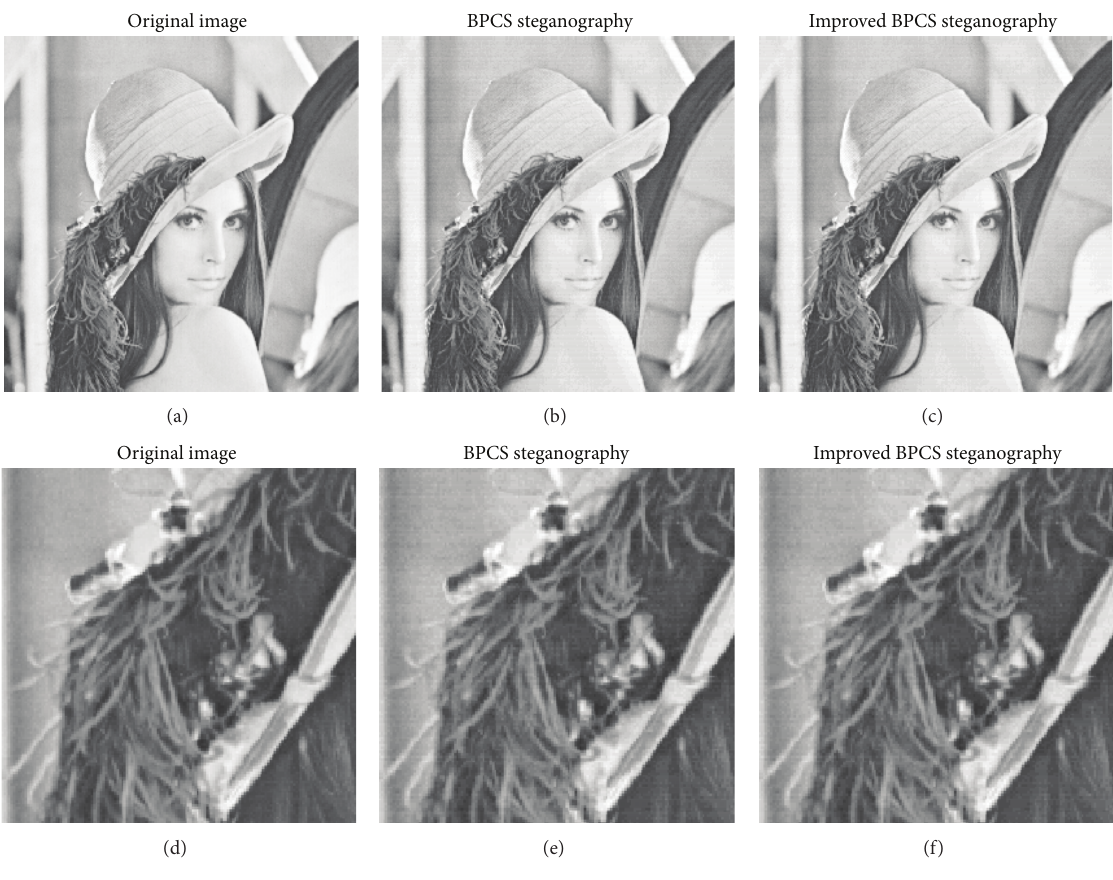
Figure 5: Comparison of BPCS and improved